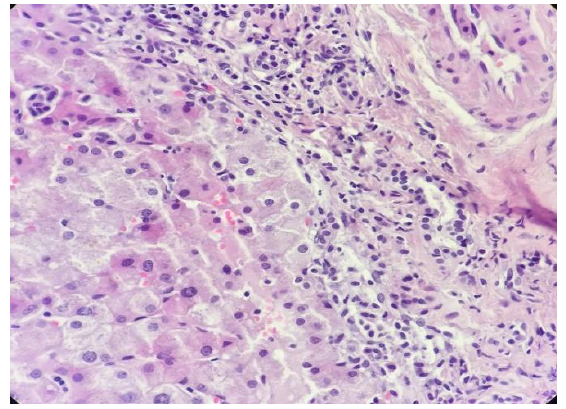
Figure 4. Liver biopsy showed peri-portal mast cell infiltration. (H&E, 400×)